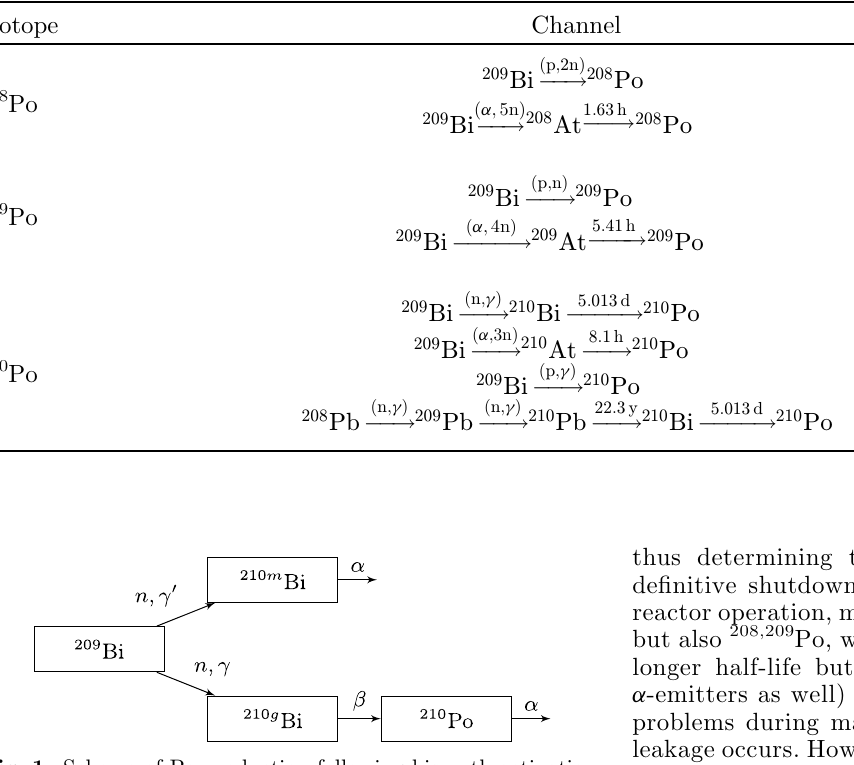
Fig. 1. Scheme of Po production following bismuth